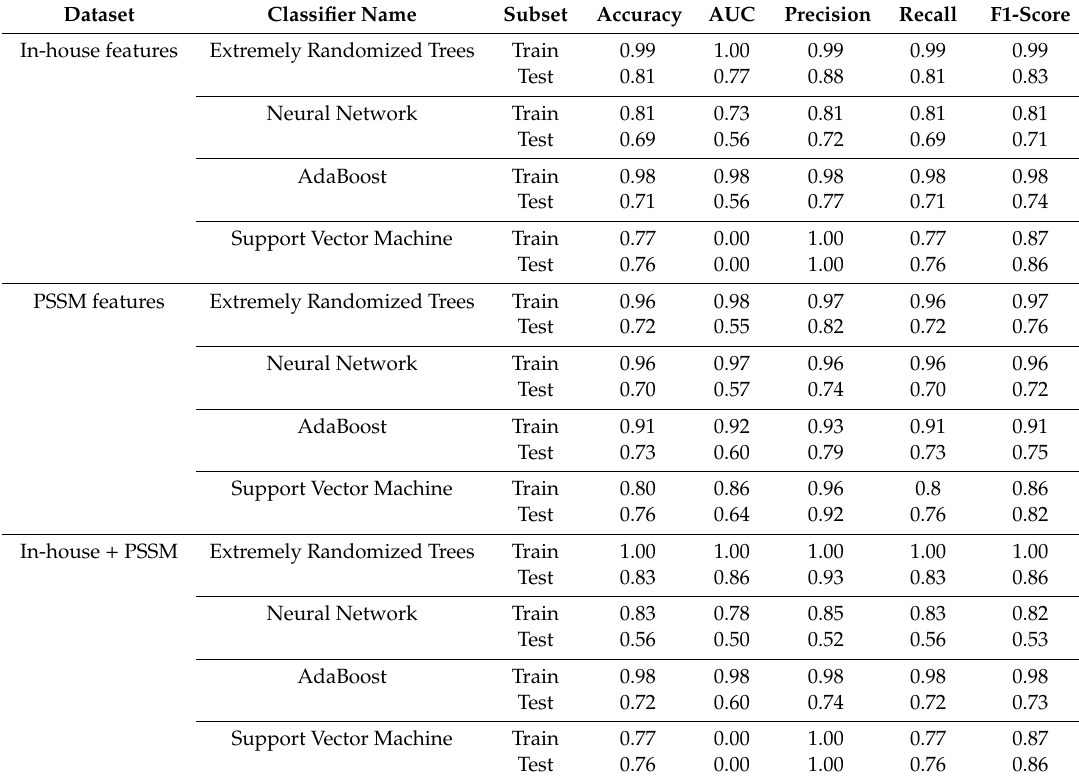
Table A1. Performance metrics (training and testing datasets) for the three studied subsets: with only the in-house features (one-hot encoding, relative position, literature based and window-based features), using only PSSM features and the joint dataset with both in-house and PSSM